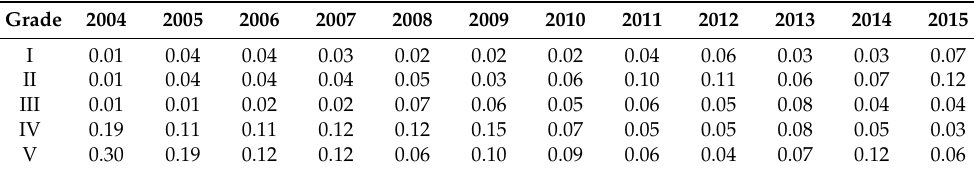
Table 8. Comprehensive Degree of Connection Determined by S-type functions.